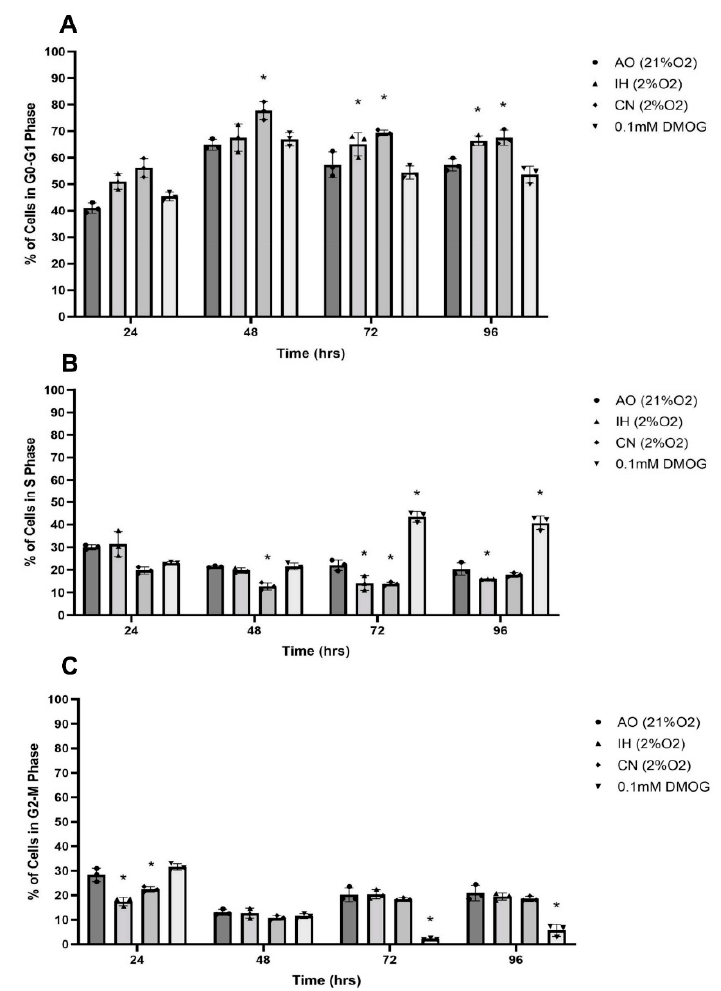
Figure 7. The cell cycle phases of PC12 cells cultured under three different culture conditions and with DMOG. PC12 cells were cultured in air oxygen (AO), intermittent hypoxia (IH) or continuous normoxia (CN) or with DMOG (0.1 mM) in AO for a 96 h time-course, and the percentage of cells in each cycle phase was analysed using a flow cytometer. ( A ) The percentage of cells in the G0/G1 phase was significantly increased in both IH and CN, while DMOG (0.1 mM) did not change it significantly. ( B ) The percentage of cells in the S phase was significantly reduced at 72 and 96 h in IH and CN, while DMOG (0.1 mM) significantly increased it at both 72 and 96 h. ( C ) The percentage of cells in the G2-M phase was significantly increased at 24 h in IH and CN; DMOG (0.1 mM) significantly reduced it at both 72 and 96 h. Data are presented as mean percentage of cells in a phase ± S.E.M, n = 3. Statistical significance of the assay was evaluated using one-way ANOVA with Tukey post hoc corrections. * indicates significant difference in comparison to control at each time point and under each oxygen culture condition ( p < 0.05).